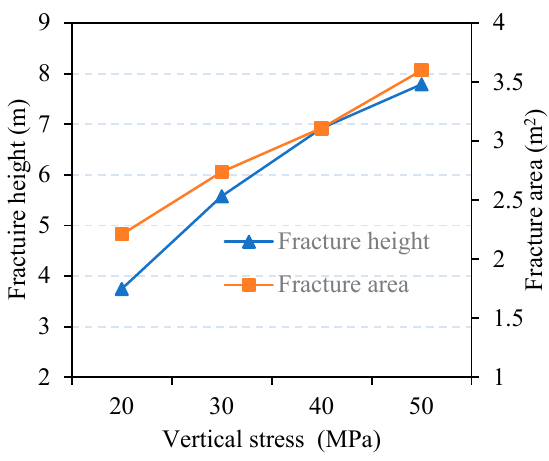
Figure 8. Variation in fracture height and fracture area versus vertical stress.